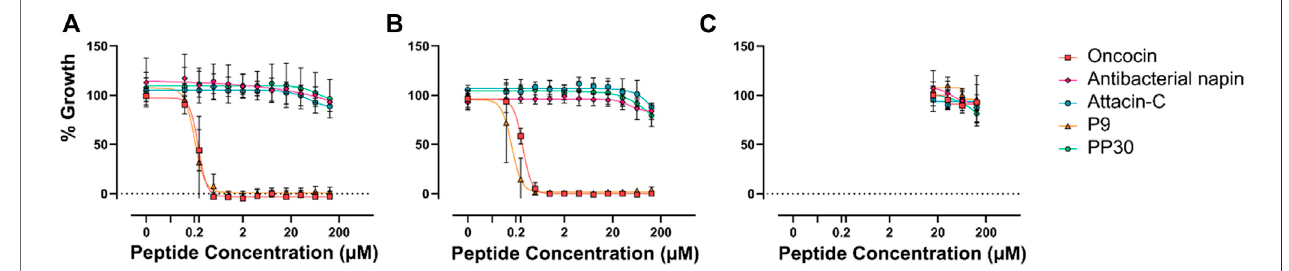
FIGURE 2 | Minimum inhibitory concentration of potential PrAMPs. Each of the potential PrAMPs were assayed for MIC against E. coli ATCC 25922 (A) , E. coli BACC 3051 (B) , and S. aureus 29213 (C) , up to 128 µM in MHB media.